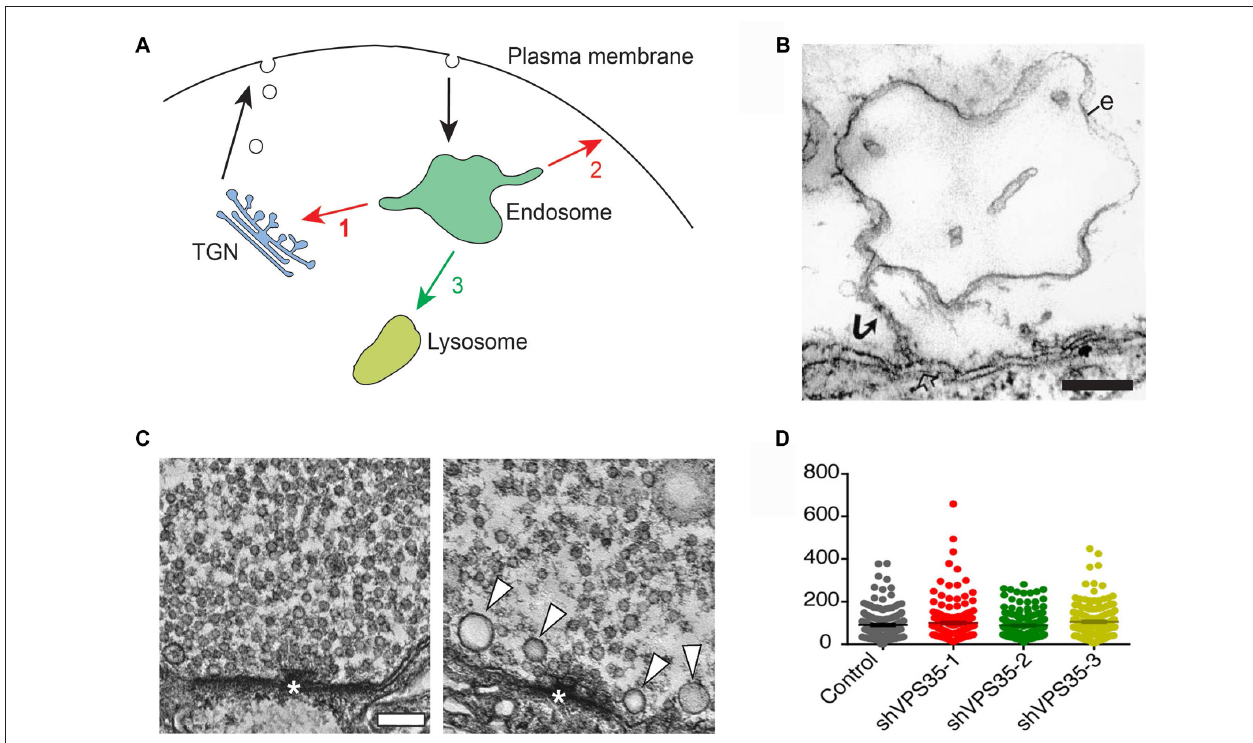
FIGURE 1 | Retromer and the trafficking of synaptic vesicle proteins. (A) Endosomal trafficking pathways in animal cells. Proteins entering endosomes can be exported retrogradely to the trans-Golgi network (TGN; 1), or recycled back to the plasma membrane (2), or transferred to lysosomes via late endosomes for degradation (3). Retromer controls pathways 1 and 2. (B) ”False” endosome induced by synaptic activity at a presynaptic release site. The electron micrograph shows an endosome-like object (e) in a repetitively stimulated lamprey reticulospinal axon. Note the connection with the plasma membrane via a narrow stalk (arrow) revealing that the endosome-like object is in fact an invagination of the plasma membrane. Bar = 200 nm (reproduced from Gad et al., 1998 with permission). (C) Deletion of VPS35 in Drosophila alters synaptic vesicles in larval motor terminals. The left micrograph shows a control motor terminal. The right micrograph shows a terminal from a larva deficient in VPS35 and expressing a non-rescuing D620N mutant form of VPS35. Note the decreased number of synaptic vesicles and the occurrence of some large vesicles (arrowheads). Bar = 100 nm (reproduced from Inoshita et al., 2017 with permission). (D) Knockdown of retromer in mouse hippocampal neurons does not alter synaptic vesicles in nerve terminals. Quantitative comparison showing that the number of synaptic vesicles is similar in nerve terminals from control neurons and from neurons treated with either of three different shRNAs for VPS35 (reproduced from Vazquez-Sanchez et al., 2018 with permission: